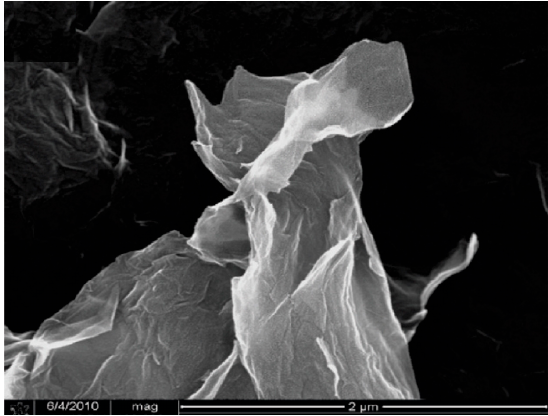
Figure 6. Scanning Electron Microscope (SEM) micrograph of GO (adapted with permission from [186]. Copyright © 2010 American Chemical Society).